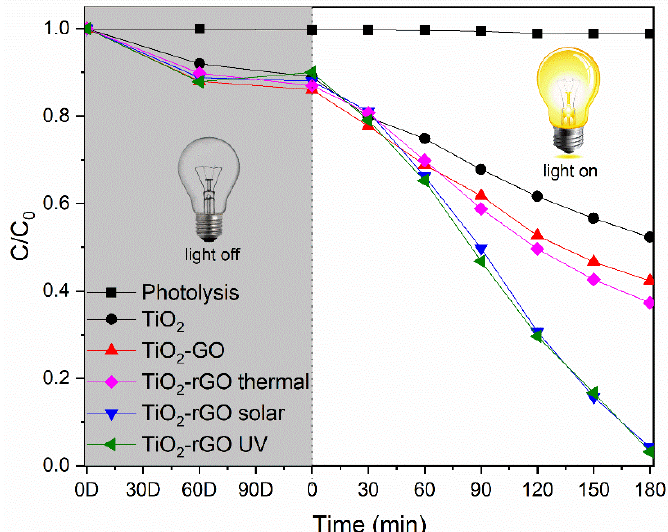
Figure 6. 2,4-D photodegradation. The experiments were conducted three times with an error below 1 %, i.e., within the symbols thickness. The letter D after the firsts four x-values indicate the dark conditions; the time 0 is equal to 120 D.